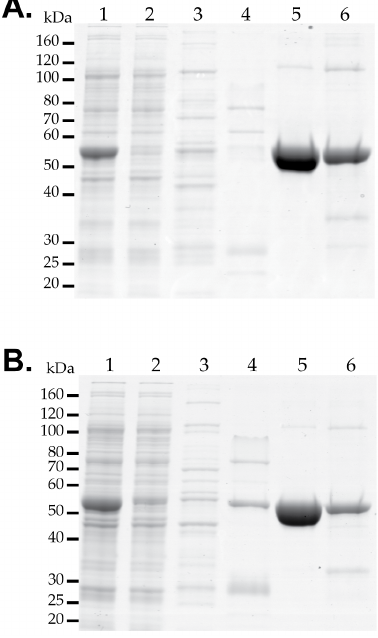
Figure 3. Purification of recombinant zfNAGS-M and zfNAGS-C. The zfNAGS-M ( A ) and zfNAGS-C ( B ) with the N-terminal